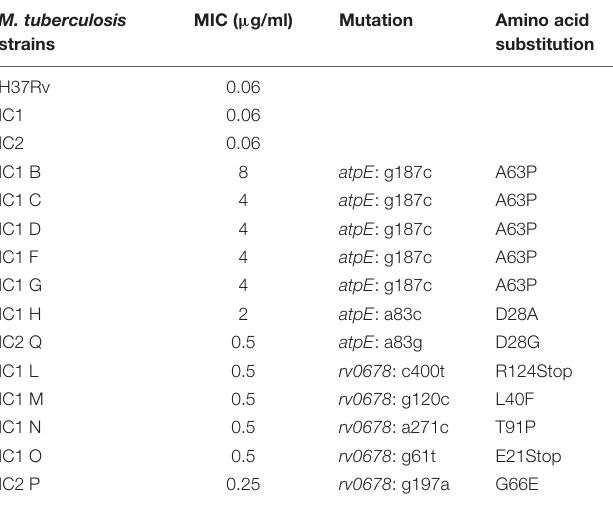
TABLE 2 | Phenotypic and genotypic characteristics of mutants resistant to BDQ obtained from M. tuberculosis clinical isolates IC1 and IC2. M. tuberculosis